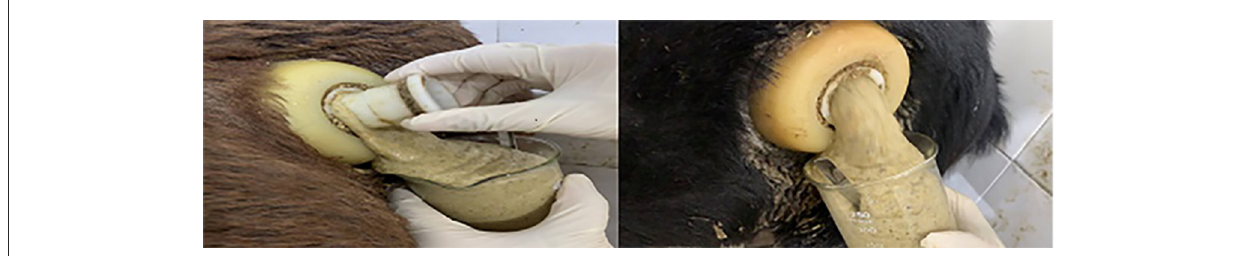
FIGURE1 Ruminal fluid coming from ruminal animals with feedlot bloat (14).